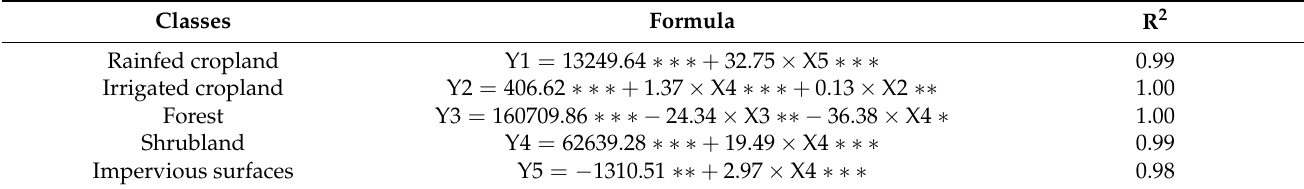
Table 5. Relationships between major LUC types areas and driving